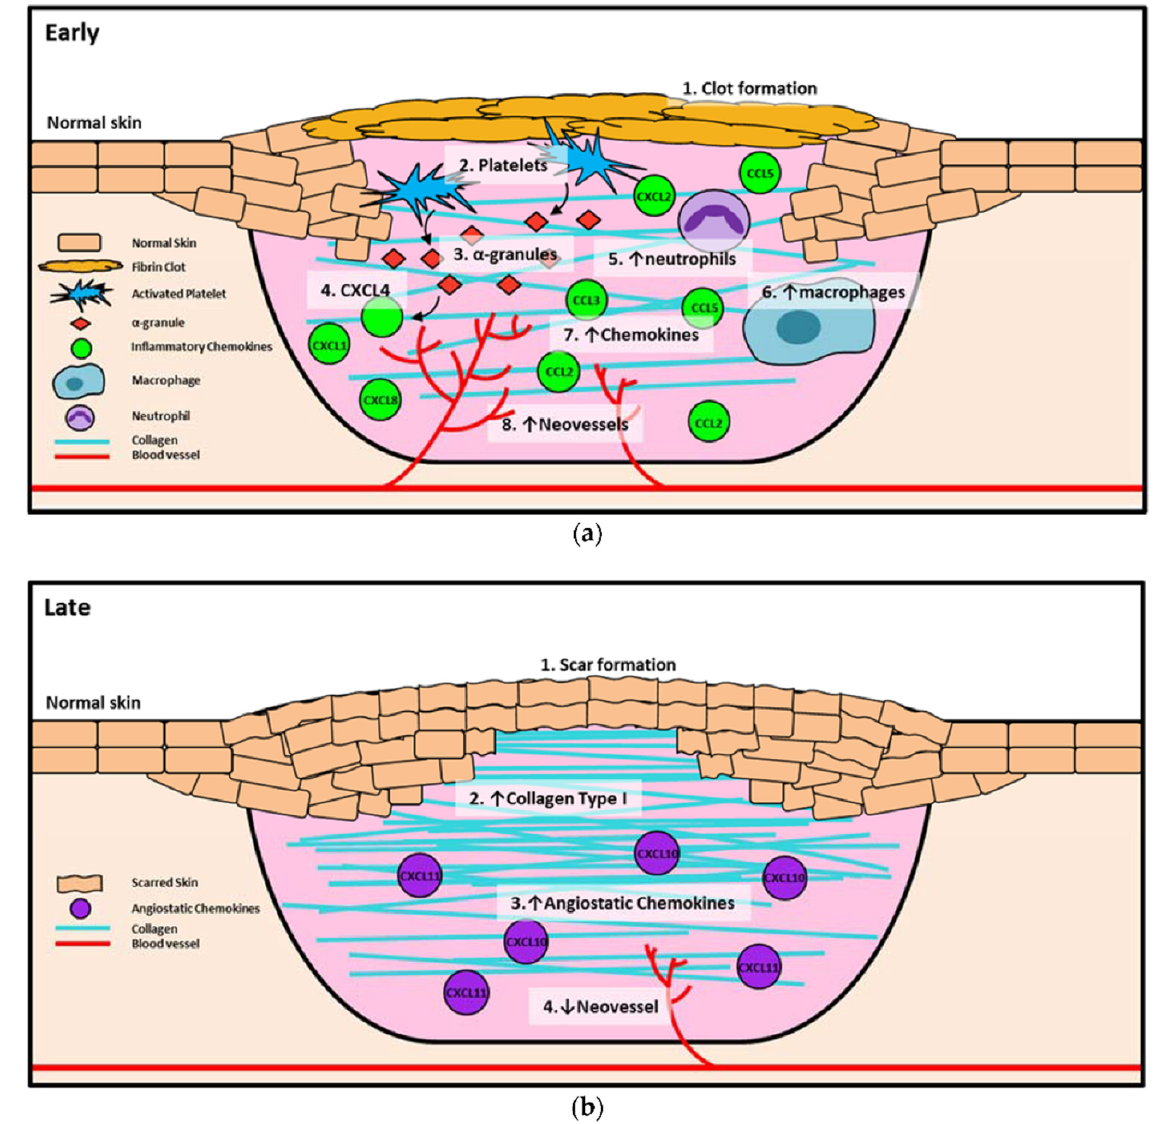
Figure 2. Chemokines in early and late phases of wound healing. ( a ) Early wound healing, including clot formation, inflammation, and proliferation. (1) Clot formation occurs to prevent the loss of blood, and (2) platelets are activated and release (3) α -granules, which in turn release (4) CXCL4 as an early inhibitor of angiogenesis. Once the clot has fully formed, other chemokines such as CXCL8, CXCL1, and CXCL2 are released by α -granules to recruit inflammatory cells, including (5) neutrophils and (6) macrophages. Neutrophils are increased early in the healing process, then macrophages soon take over as the primary inflammatory cell. Neutrophils and macrophages release (7) chemokines such as CCL2, CCL3, and CCL5 into the wound to promote the recruitment of more inflammatory cells that release pro-angiogenic growth factors, which in turn (8) increase neovessel formation in the wound. ( b ) Late wound healing is the remodeling stage. In this stage, the wound is fully healed and (1) a scar has formed. Type III collagen converts to (2) type I collagen to promote scar formation and create a more stable wound seal. During the remodeling process (3), angiostatic chemokines (CXCL10, CXCL11) promote the (4) regression of neovessels, as there is no longer a requirement for enhanced blood flow or the recruitment of immunological cells to the site. The symbol ↓ indicates decrease; ↑ indicates increase. The figure has been reprinted (adapted) with permission from Ref. [60] under the terms and conditions of the Creative Commons Attribution (CC BY) license (http://creativecommons.org/licenses/by/4.0/ (accessed on 26 June